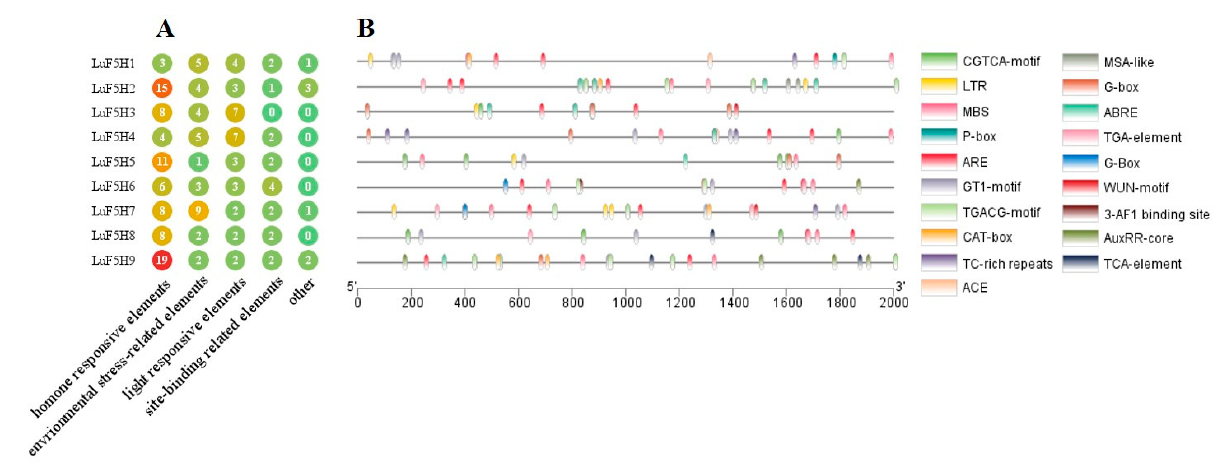
Figure 4. Cis -acting elements in LuF5H promoters. ( A ) Each LuF5H promoter contains the number of cis -acting elements detected, which are divided into four types. ( B ) Visualization of hormone- responsive elements in the LuF5H promoters by TBtools.